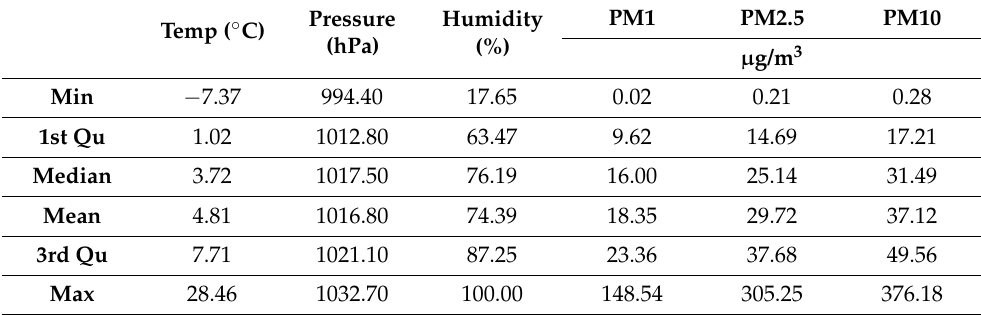
Table 1. Summary of basic statistics for the measured parameters from Airly sensors in spring in Krakow, 2021, during the COVID-19